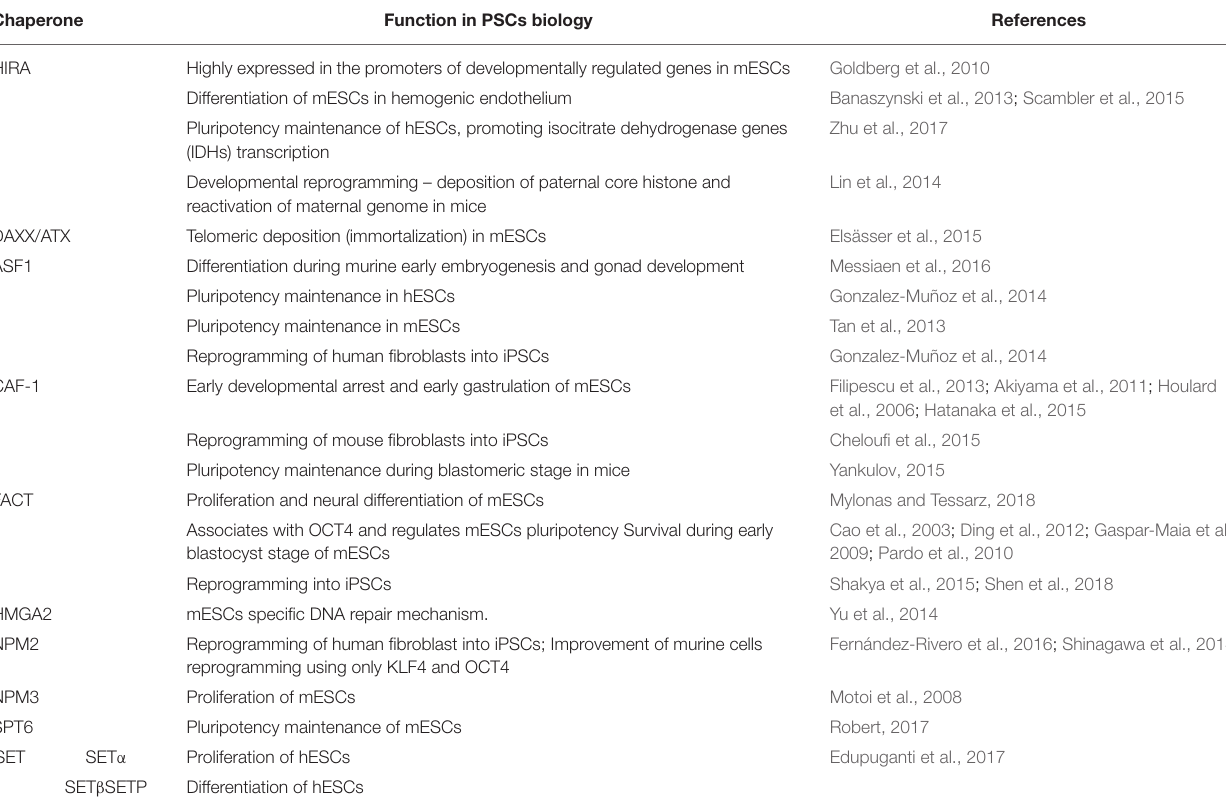
TABLE 1 | Major classes of histone chaperones and their function in stemness of different PSCs models. Chaperone Function in PSCs